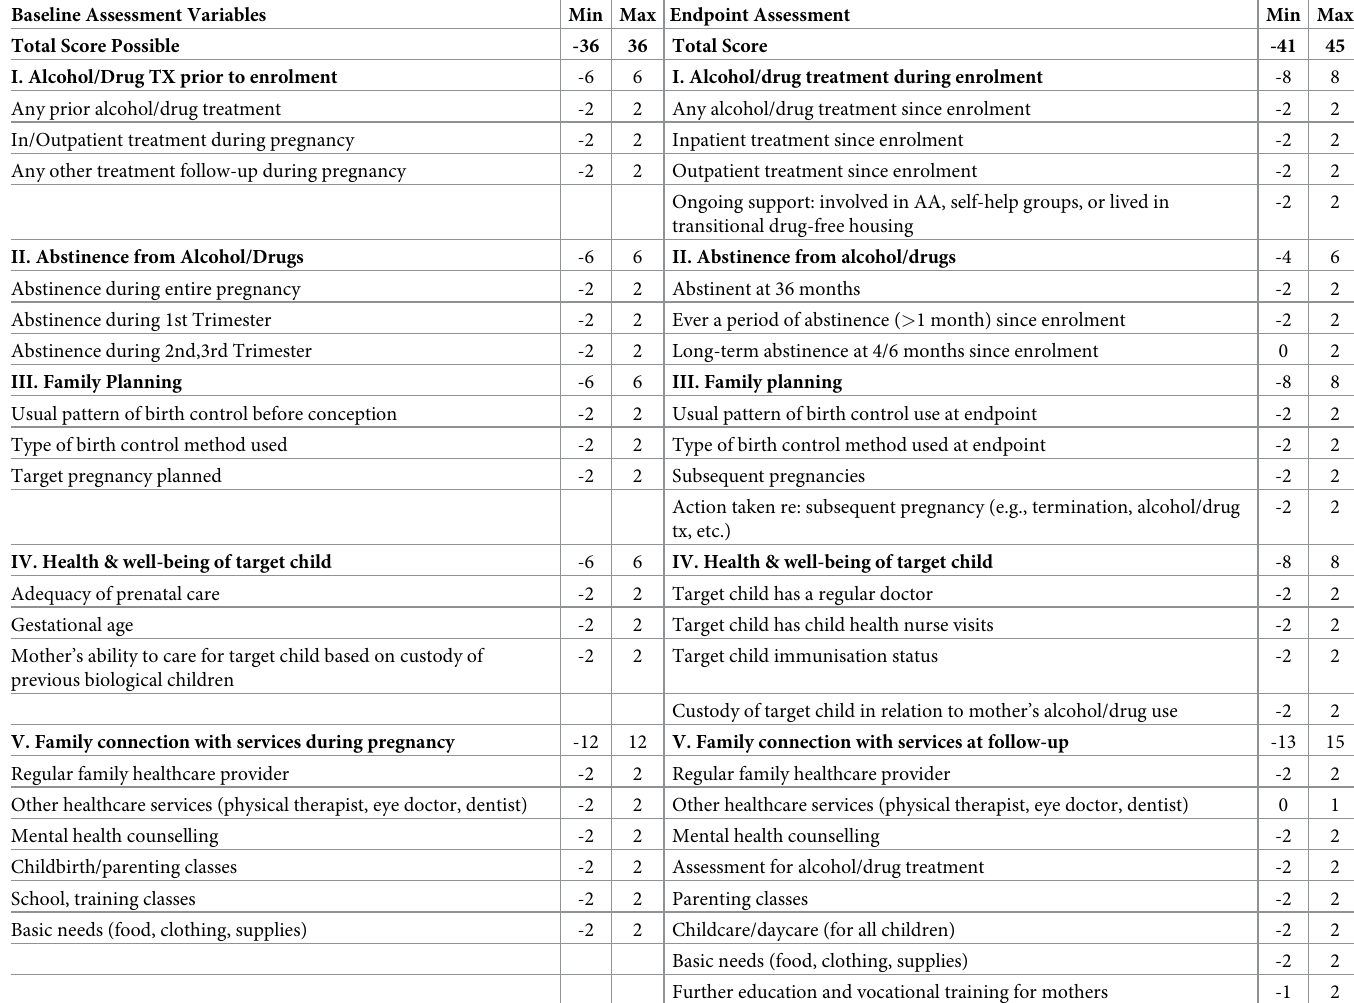
Table 1. ASI composite